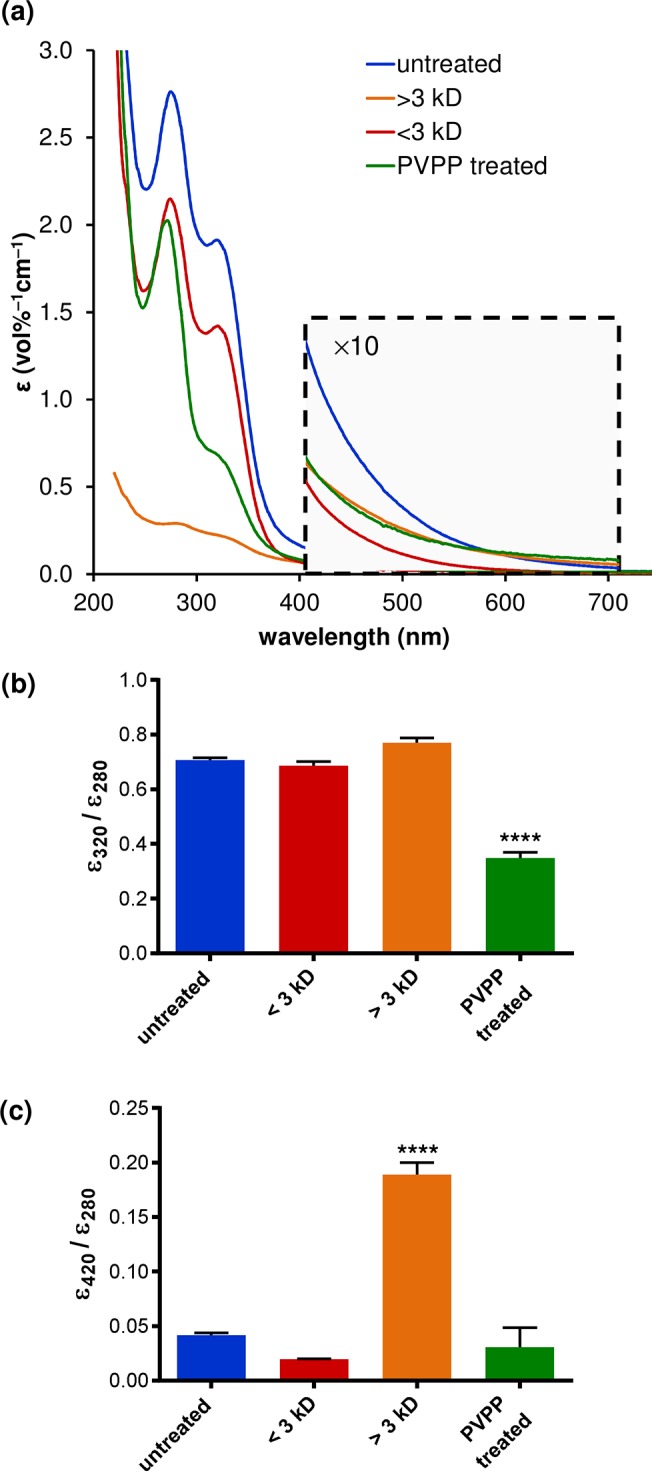
(a) UV-vis spectra of coffee brew following various treatments; quantification at discrete wavelengths associated with (b) total protein and polyphenol content (280 nm, 320 nm) and (c) melanoidins (420 nm).Consistent with a reduction in chlorogenic acid content [3], a significant decrease in the relative absorbance at 320 nm versus 280 nm was observed following phenolic extraction with PVPP, (one-way ANOVA, F = 24.77, P < 0.0001, n = 3; Holm-Šídák test, ****P < 0.0001 vs. untreated, < 3 kD and > 3 kD). A significant increase in the relative absorbance at 420nm versus 280 nm was also observed in the HMW fraction following 3 kD filtration (one-way ANOVA, F = 57.91, P < 0.0001, n = 3; Holm-Šídák test, ****P < 0.0001 vs. untreated, < 3 kD, PVPP treated), in keeping with brown color intensity arising from HMW melanoidins.